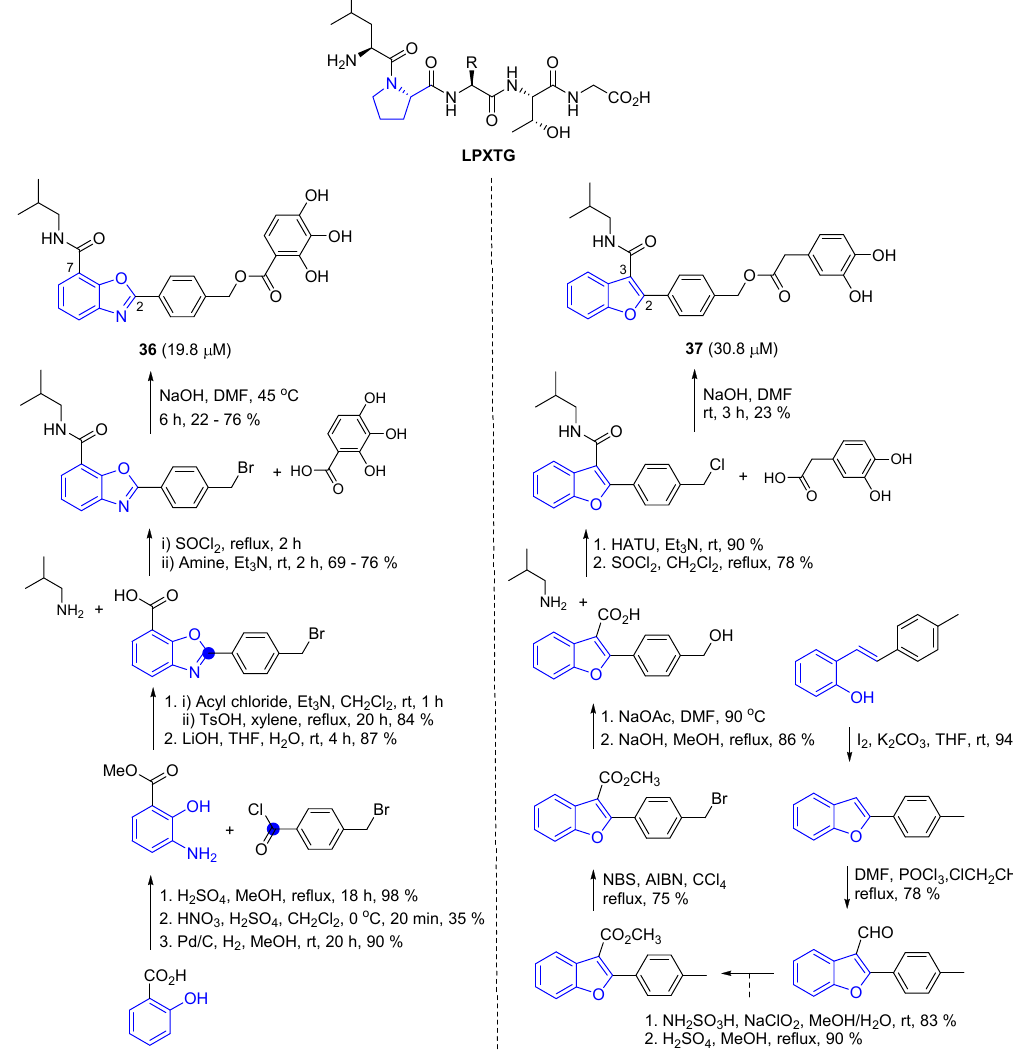
Scheme 8. Construction of the benzo[d]oxazole and benzofuran skeleton molecules (IC 50 values are given in parentheses)